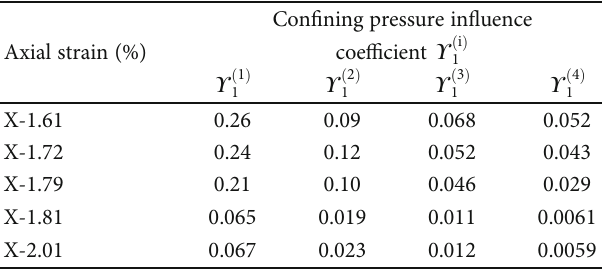
Table 11: The con fi ning pressure in fl uence coe ffi cient of water- bearing specimen.